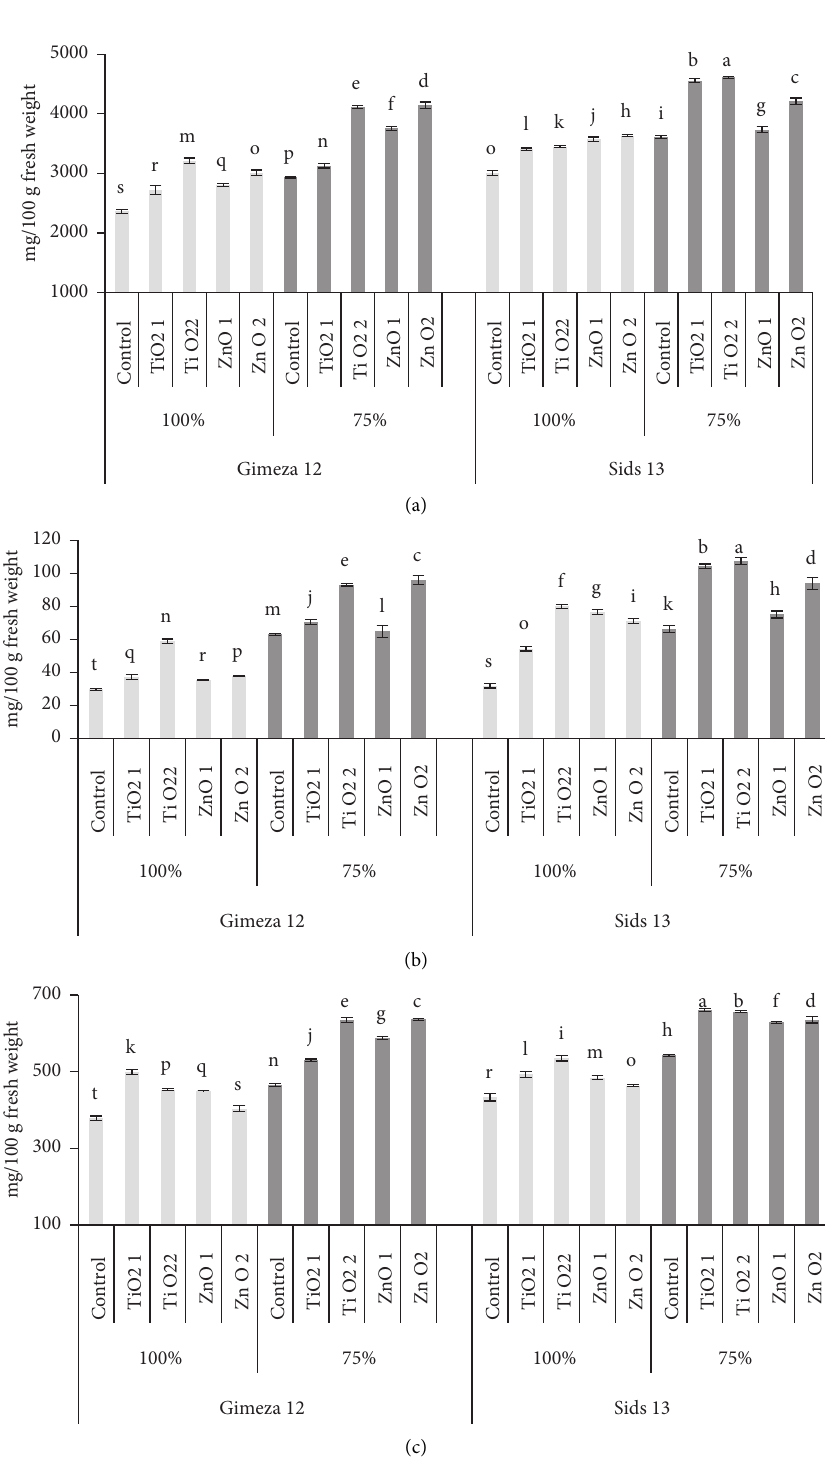
Figure 5: The effect of different concentrations of nano-TiO 2 or nano-ZnO (5 and 10mg/L) on total soluble sugar (a), proline (b), and free amino acids (c) of both wheat cultivars (Gimeza 12 and Sids 13) subjected to different levels of water irrigation requirement at 75 days from sowing. TiO 2 1 � 5mg/L, TiO 2 2 � 10mg/L, ZnO 1 � 5mg/L, and ZnO 2 �